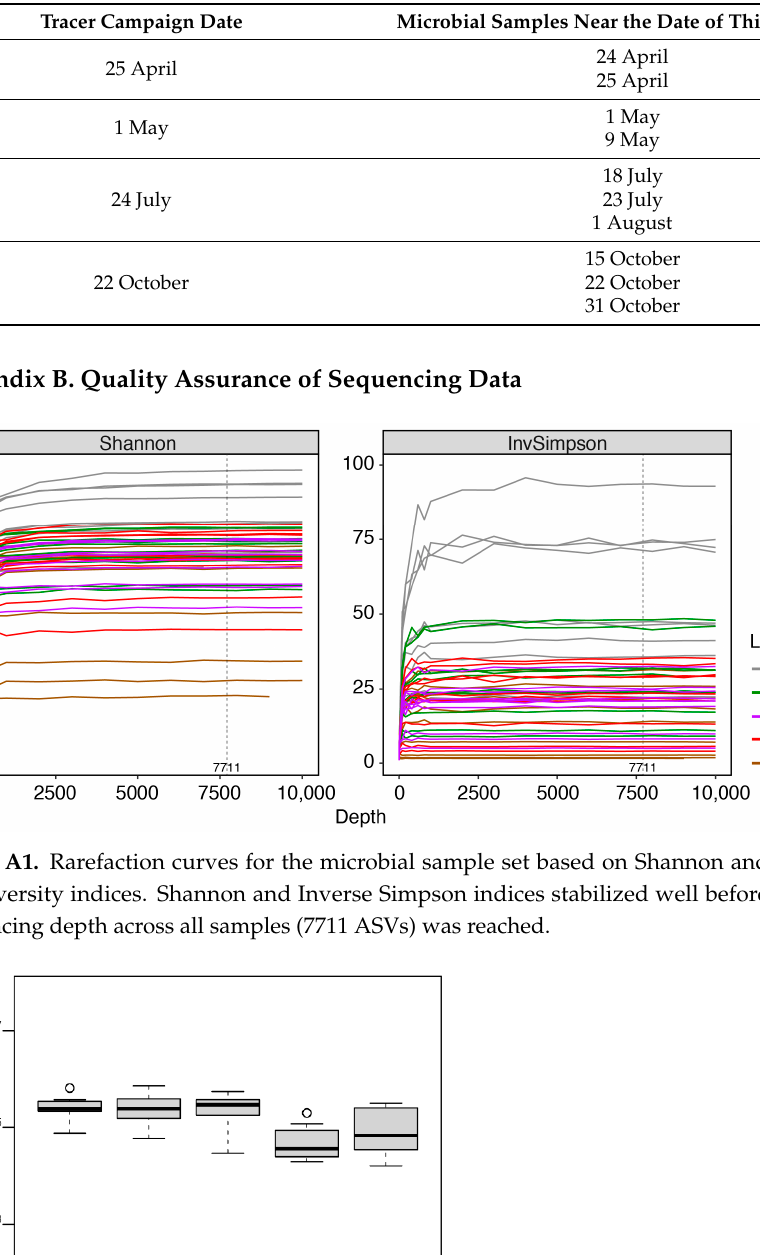
Table A1. Summary of tracer campaign dates and each tracer campaign’s closest microbial sampling dates. Note that on each microbial sampling date, one microbial sample was obtained from each of the five wells (Inj, PDT, PST, PI, and PB). Ten microbial sampling dates with five samples total per date leads to a total of 50 microbial samples relevant to this study.